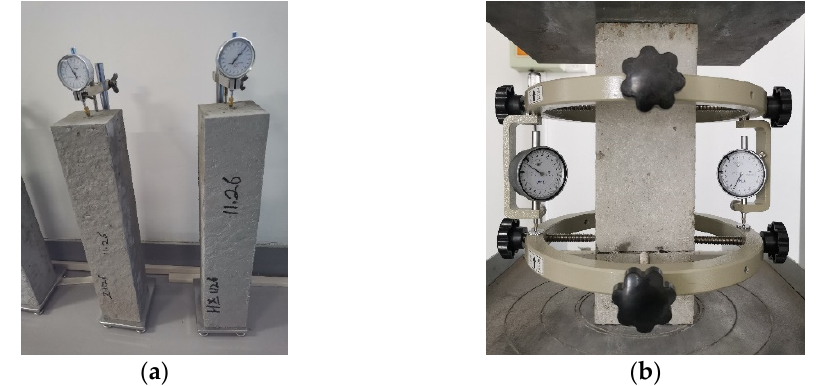
Figure 4. Mechanical test of the concrete part. ( a ) Concrete early shrinkage test; ( b ) Concrete elastic modulus test.